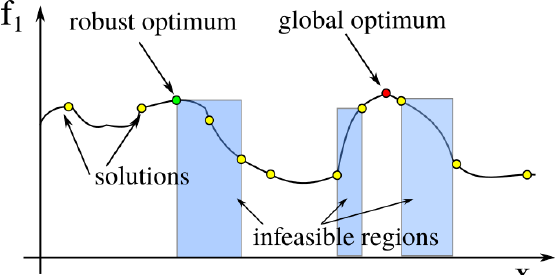
Figure 6. The infeasible regions in the case of a type II robustness. These regions are calculated from the (badly) sampled points of the objective function